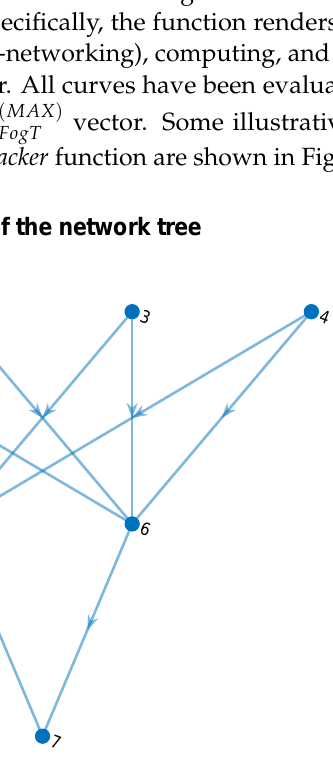
Figure 7. An illustrative screenshot of the Fog topology rendered by the execution of the plot_Topology